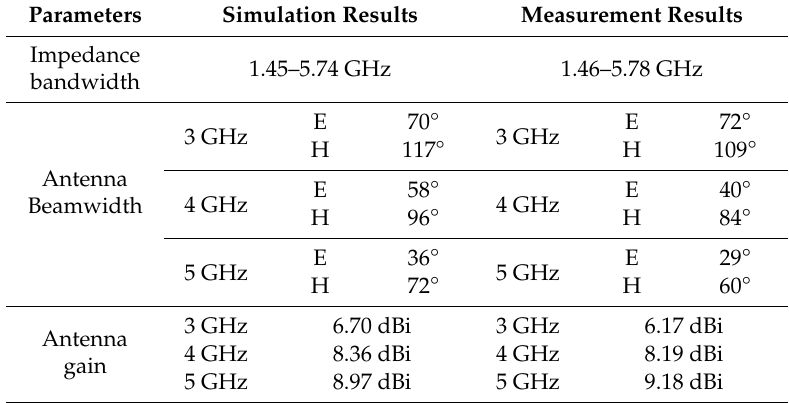
Table 1. Comparisons of simulation and measurement